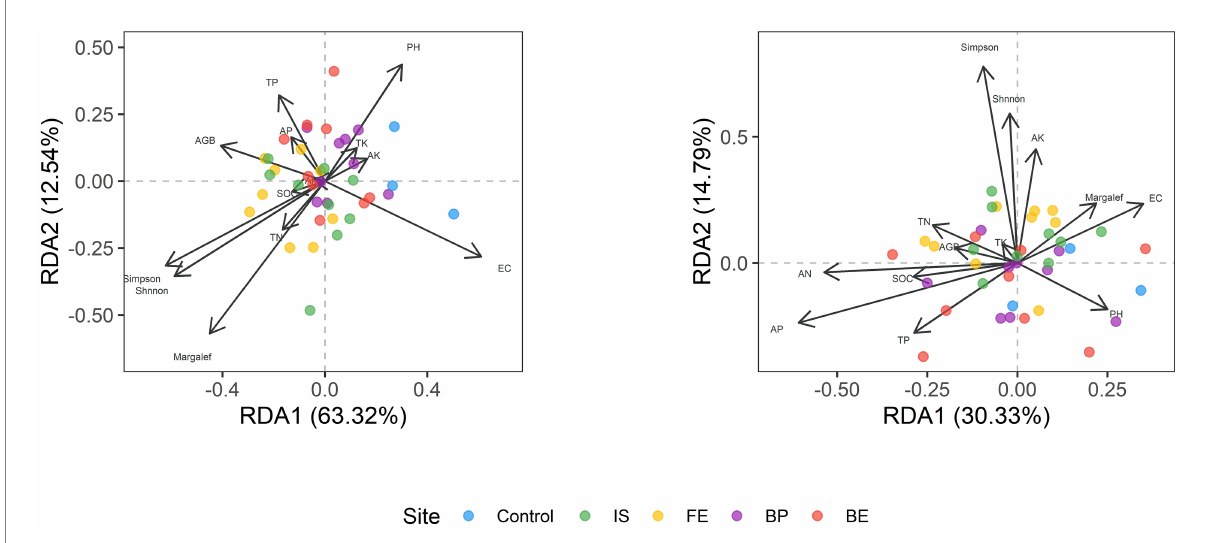
FIGURE 4 RDA analysis of soil bacteria and fungi with plant communities and soil properties at different sites of PV